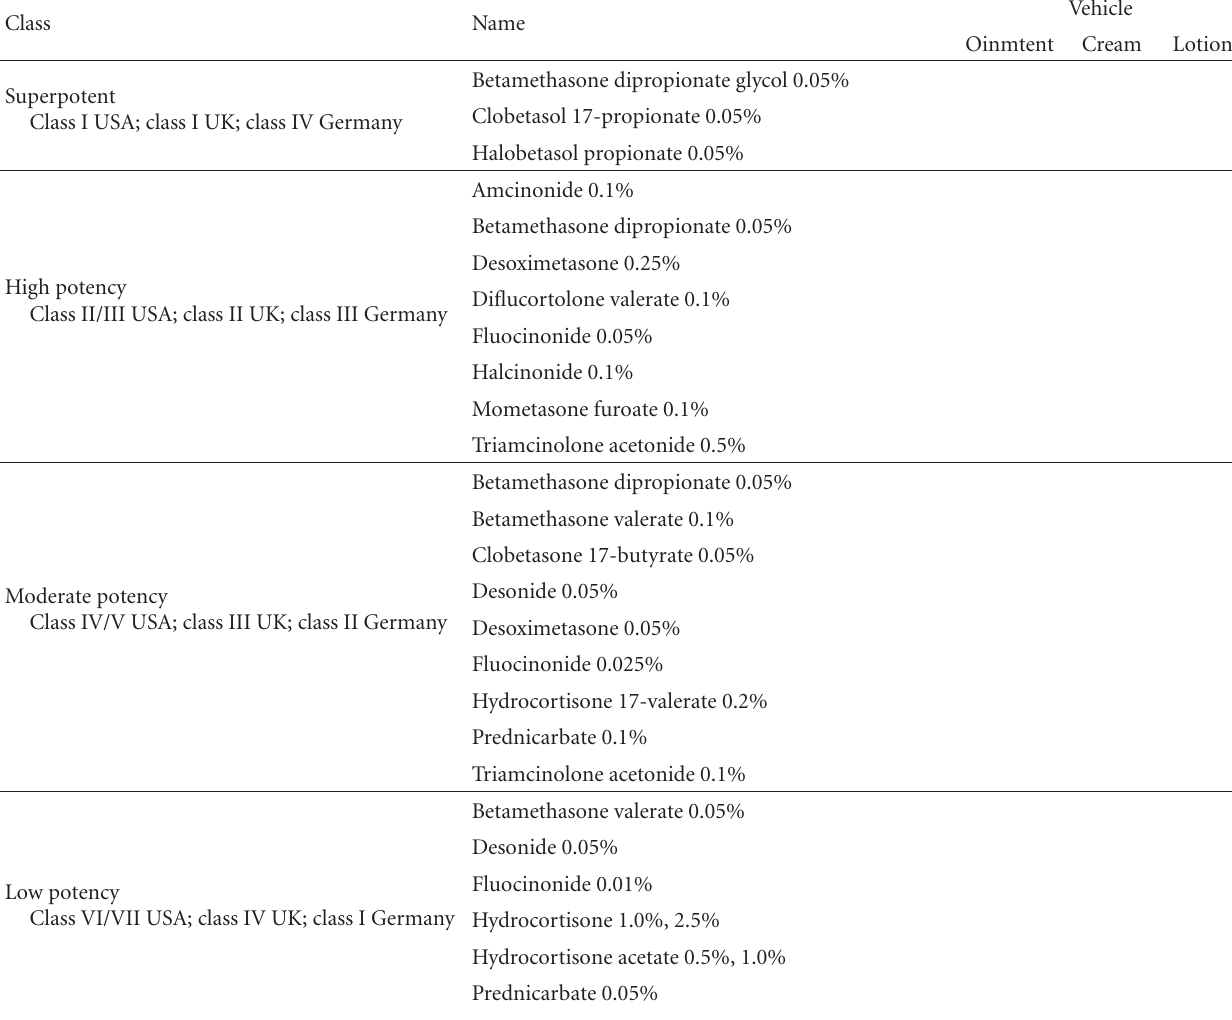
Table 1: Corticosteroid classification system, adapted from